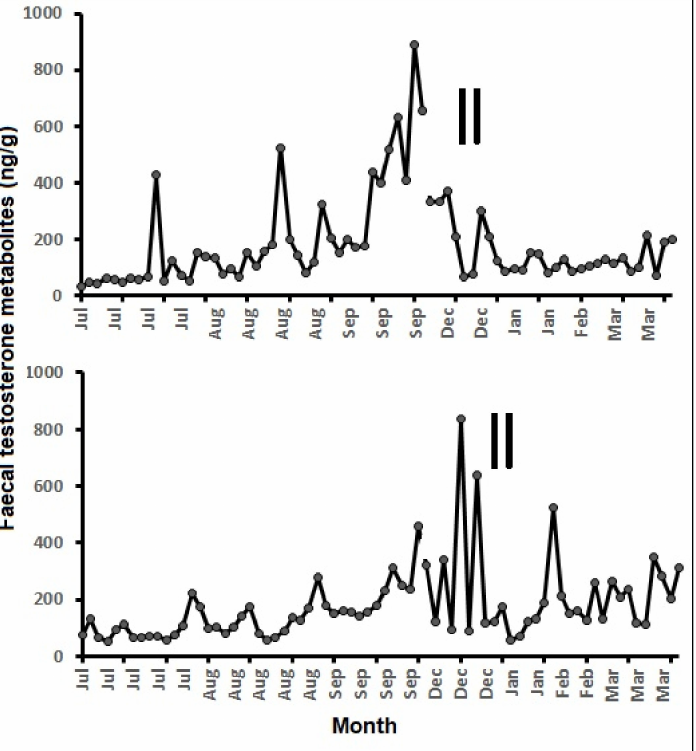
Figure 5. Fecal testosterone metabolite concentrations of two males monitored at PHCP, Guwahati (vertical bars—mating